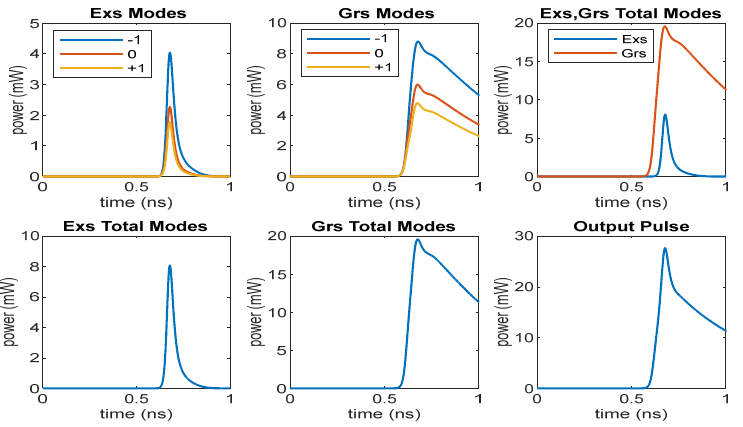
Figure 7. Output pulses for an I rf current of 40 mA.